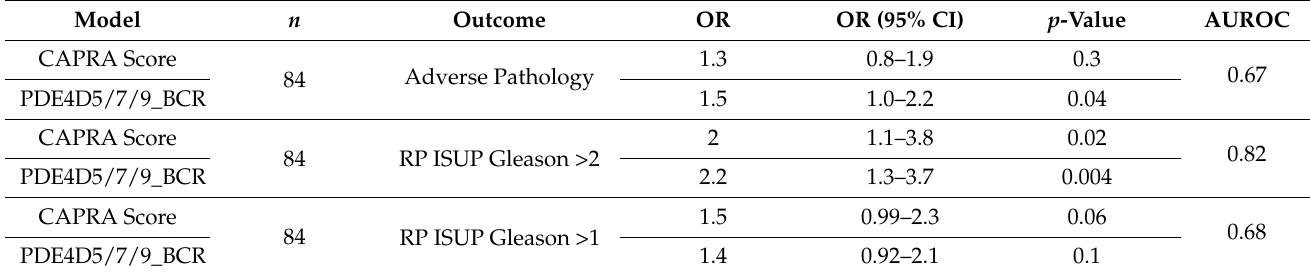
Table 4. Multivariable logistic regression (MVLR) modeling of the PDE4D5/7/9_BCR risk model adjusted for the pre-surgical CAPRA score. The tested outcomes were: (i) Adverse Pathology defined as any ISUP pathological Gleason grade >2, or pathological pT stage > pT3a, or tumor penetrated prostate capsular status, or pN1 disease; (ii) any ISUP pathological Gleason >2; (iii) any ISUP pathological Gleason >1. OR–Odds ratio; OR (95% CI)–95% confidence interval of the Odds ratio; AUROC–Area Under the ROC